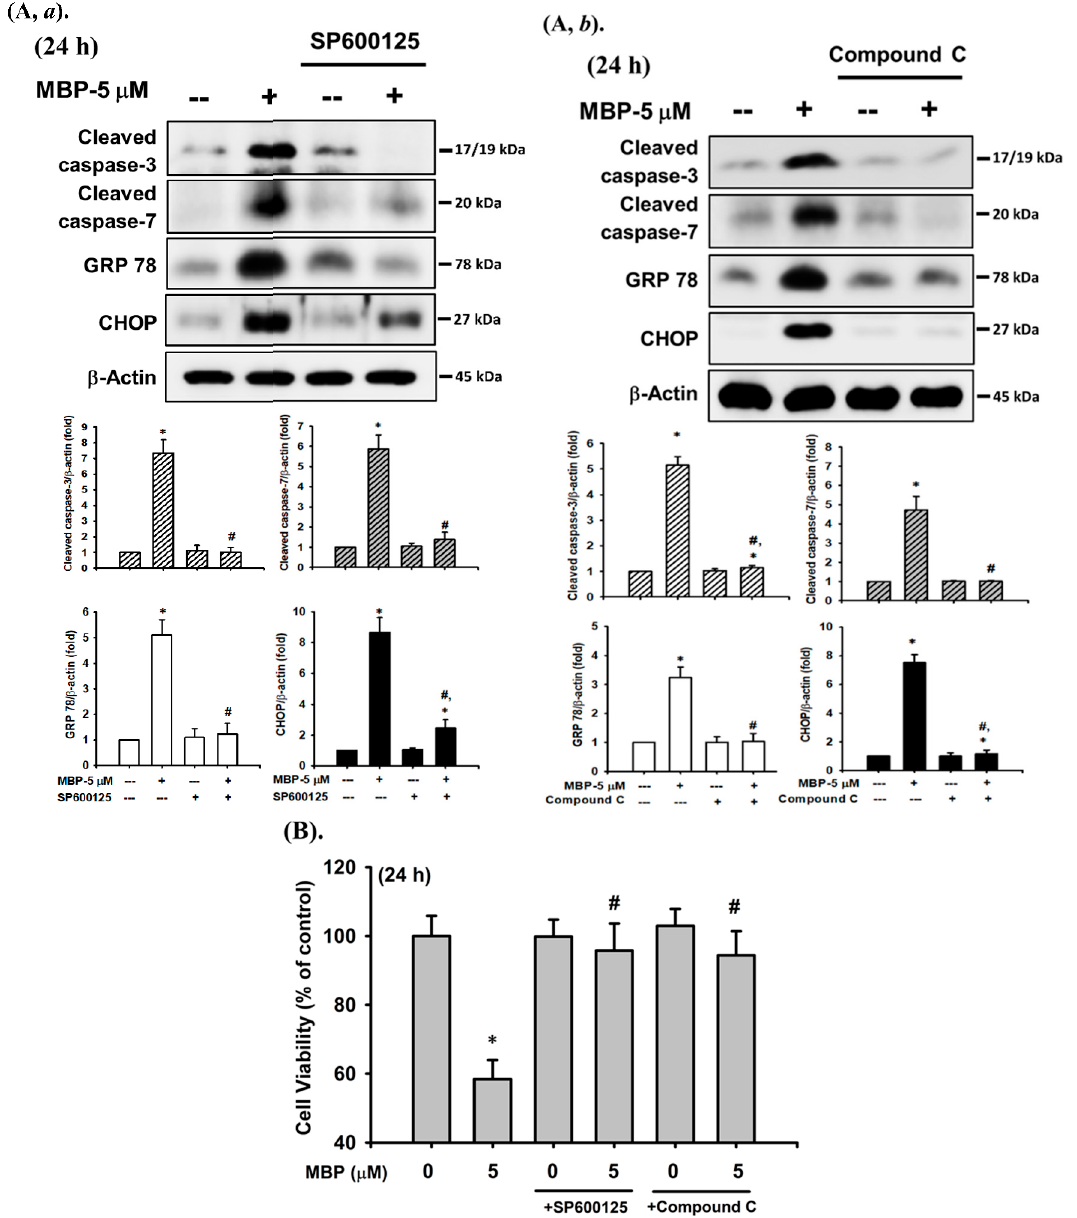
Figure 5. JNK- and AMPK α -mediated signaling pathways played critical roles in MBP-induced apoptosis in β -cells. RIN-m5F cells were treated with MBP (5 μ M) for 2 – 24 h in the presence or absence of the specific inhibitor of JNK1/2 (SP600125 — 10 μ M; ( A, a ) and B ) and AMPK α (compound C — 10 μ M; ( A, b ) and B ). ( A ) The protein expression of cleaved caspase-3 and -7, cleaved PARP, GRP 78, and CHOP was determined using Western blot analysis. The quantification was performed using densitometric analysis. ( B ) The cell viability was detected using the MTT assay. Data are presented as the mean ± S.D. of four independent experiments assayed in triplicate. * p < 0.05 compared to the vehicle control. # p < 0.05 compared to treatment with MBP alone.